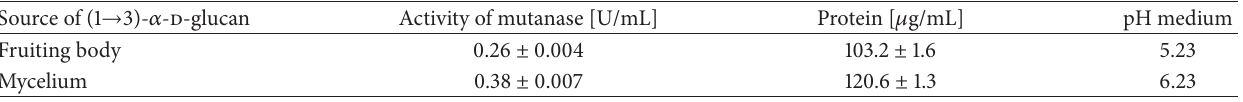
Results are shown as mean ± SD of three independent